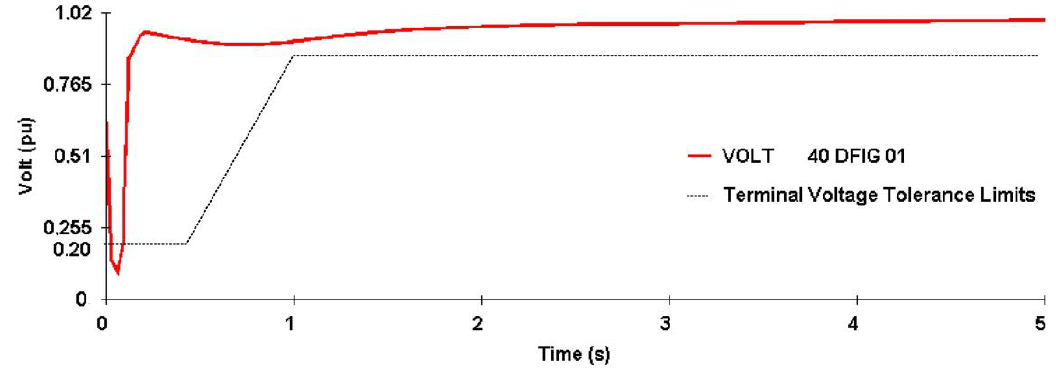
Figure 12. Doubly-fed induction generator (DFIG) terminal voltage at bus 40 after a short circuit in line LT 28–29.